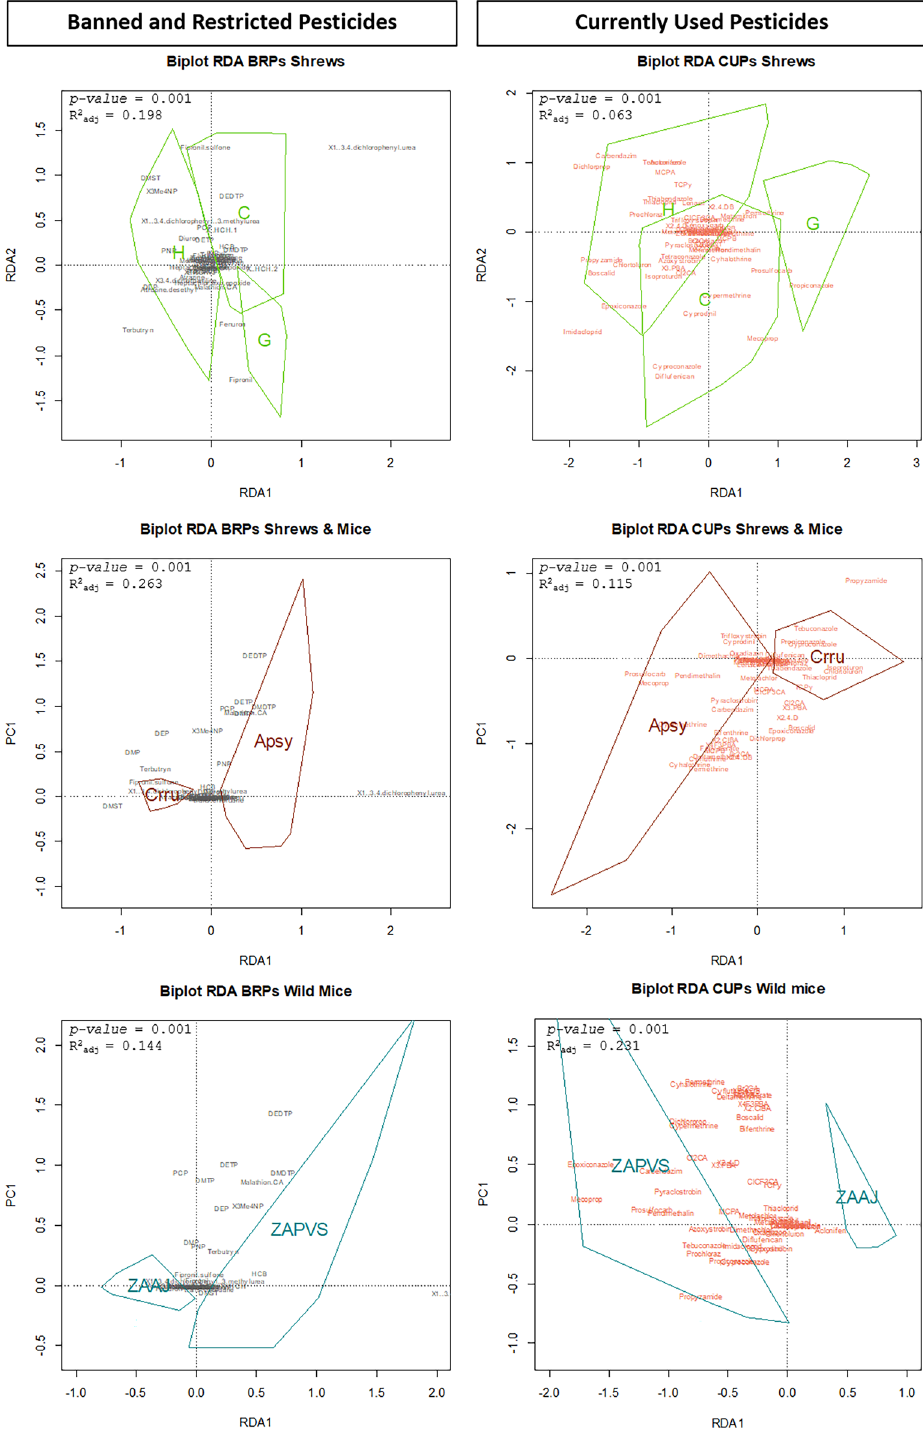
Figure 3. Influence of habitat, species, and sampling site on small mammal contamination by pesticides: correlation biplots of redundancy analyses. The factor “organic farming” is not displayed since not statistically significant ( p-value > 0.05). C = cereals, G = grasslands, H = hedgerows; Crru = Crocidura russula shrew, Apsy = Apodemus sylvaticus wood mouse; ZAAJ = Zone Atelier Arc Jurassien; ZAPVS = Zone Atelier Plaine et Val de Sèvre; R 2 adj : adjusted R squared. Groups are dispayed according to convex hulls. See Tables 1 and 2 for detailed meaning of compound